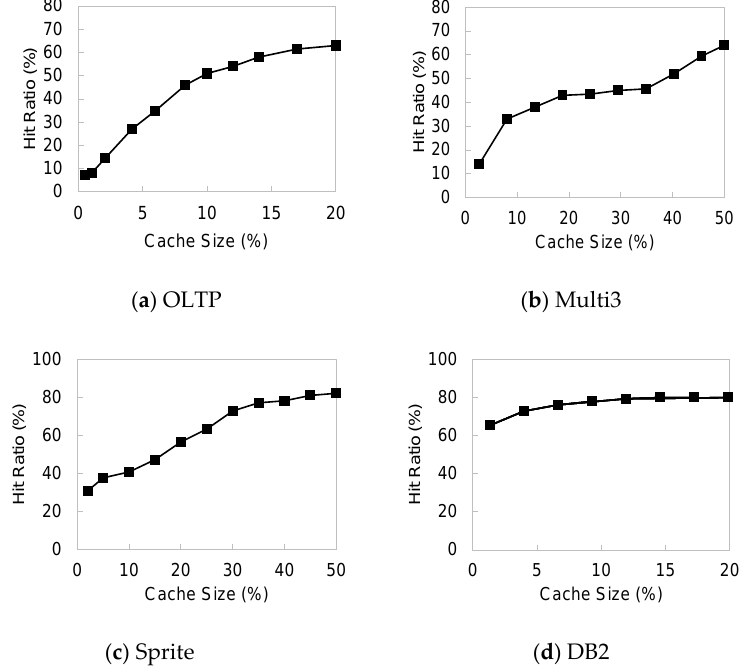
Figure 1. Buffer cache performance in general purpose systems.